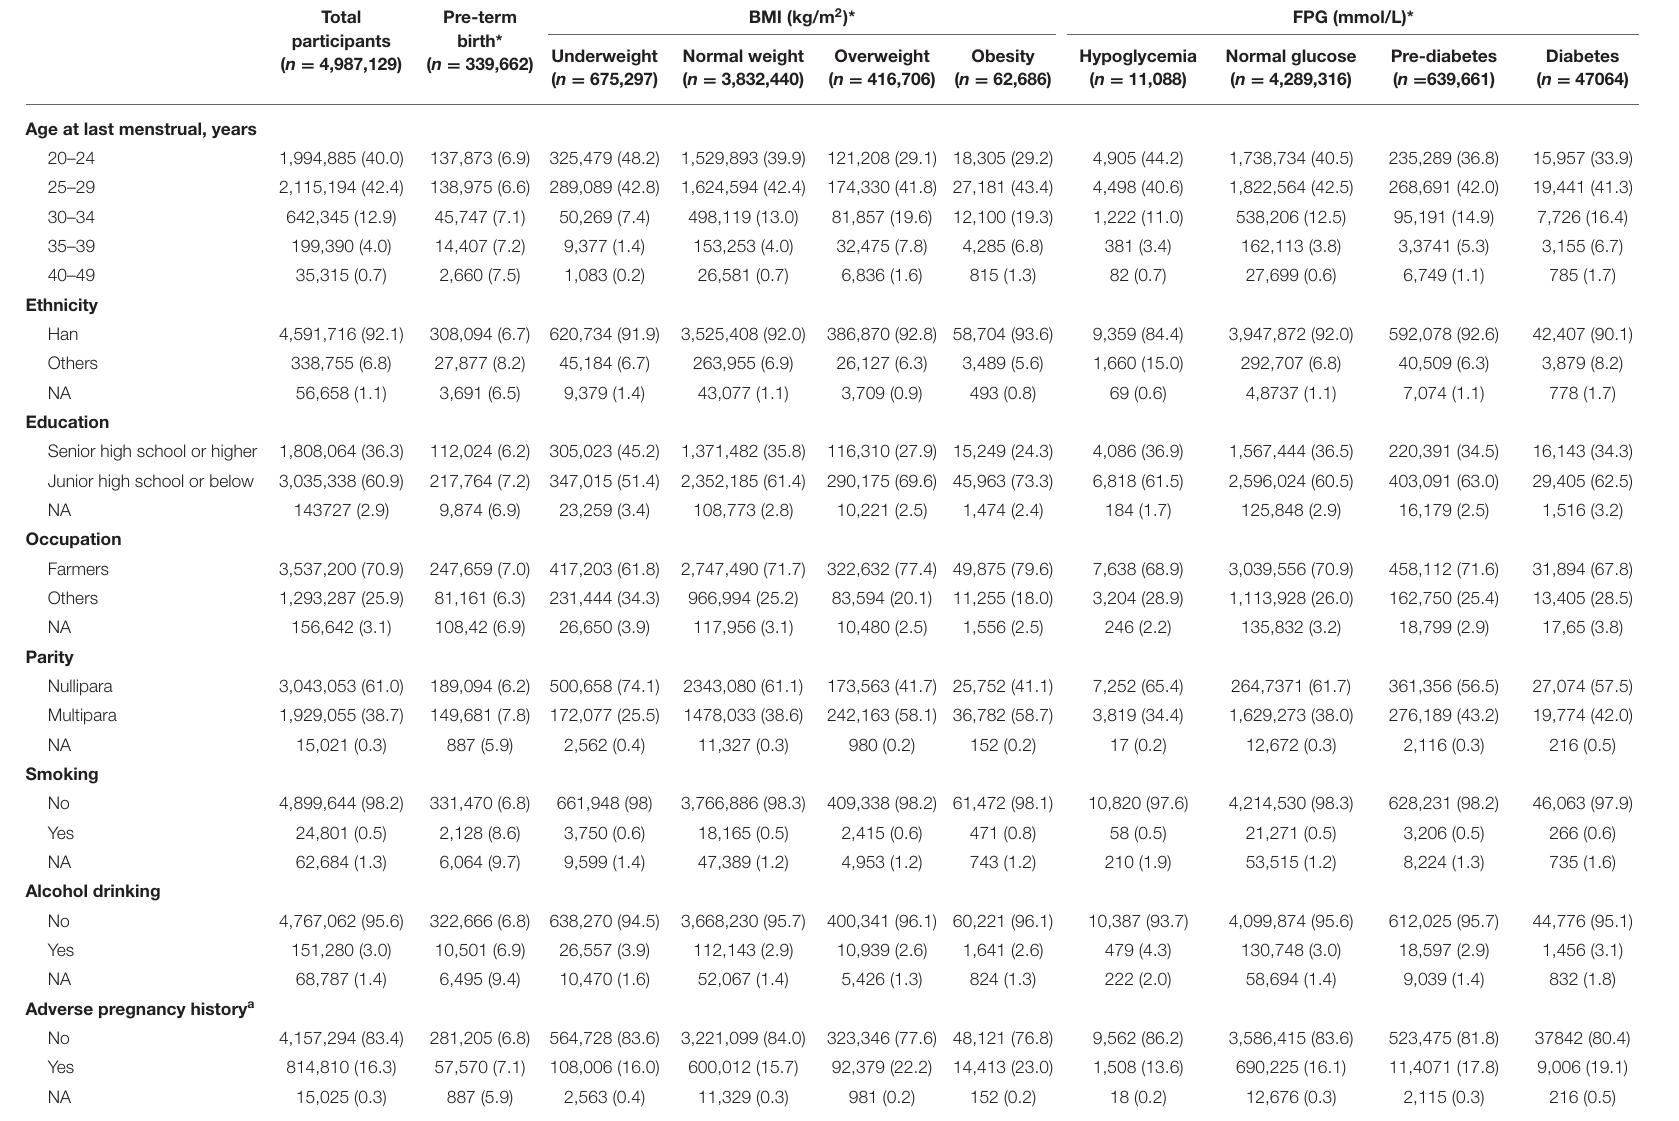
TABLE 1 | Demographic and clinical characteristics by pre-conception body mass index and fasting plasma